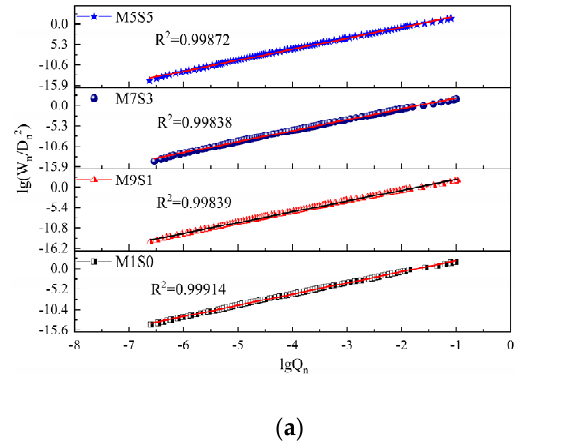
Figure 11. Scatter diagram for the Menger sponge model.( a ) Different slag contents.( b ) Different